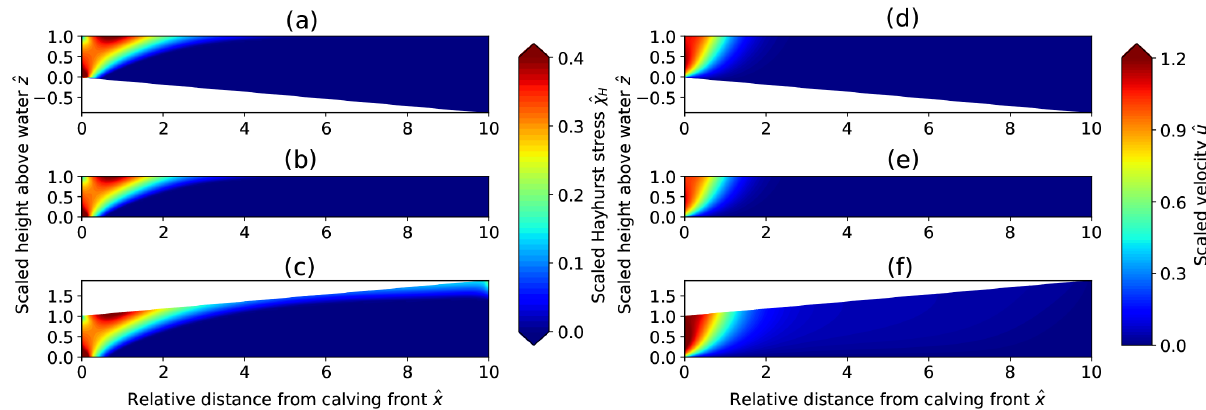
Figure 7. Sensitivity experiments result for an inclined surface (c, f) , reverse bed (a, d) and the simple rectangular geometry (b, e) . The left and right panels show the scaled Hayhurst stress and velocity distributions, respectively.